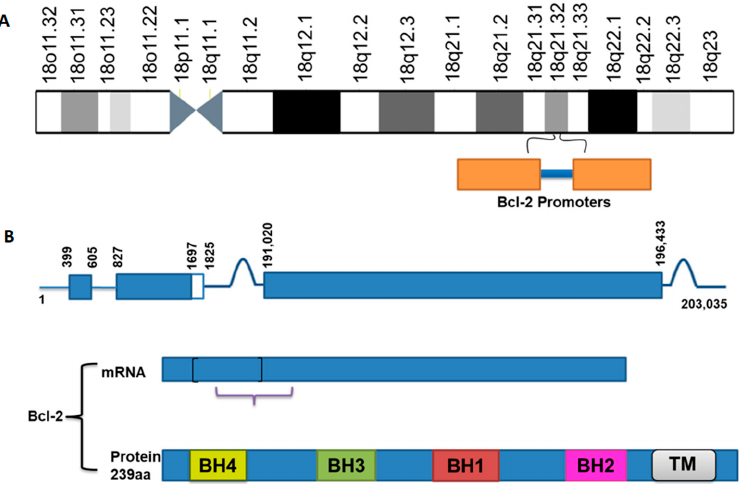
Figure 2. Structural composition of Bcl-2.( A ) Figure indicating the position of the Bcl-2 gene and promoters in the human chromosome. ( B ) The figure shows the Bcl-2 gene composed of three exons, exon 1 and exon 2 encoding the four BH (BH1-4) domains and exon 3 encoding the transmembrane (TM) domain.